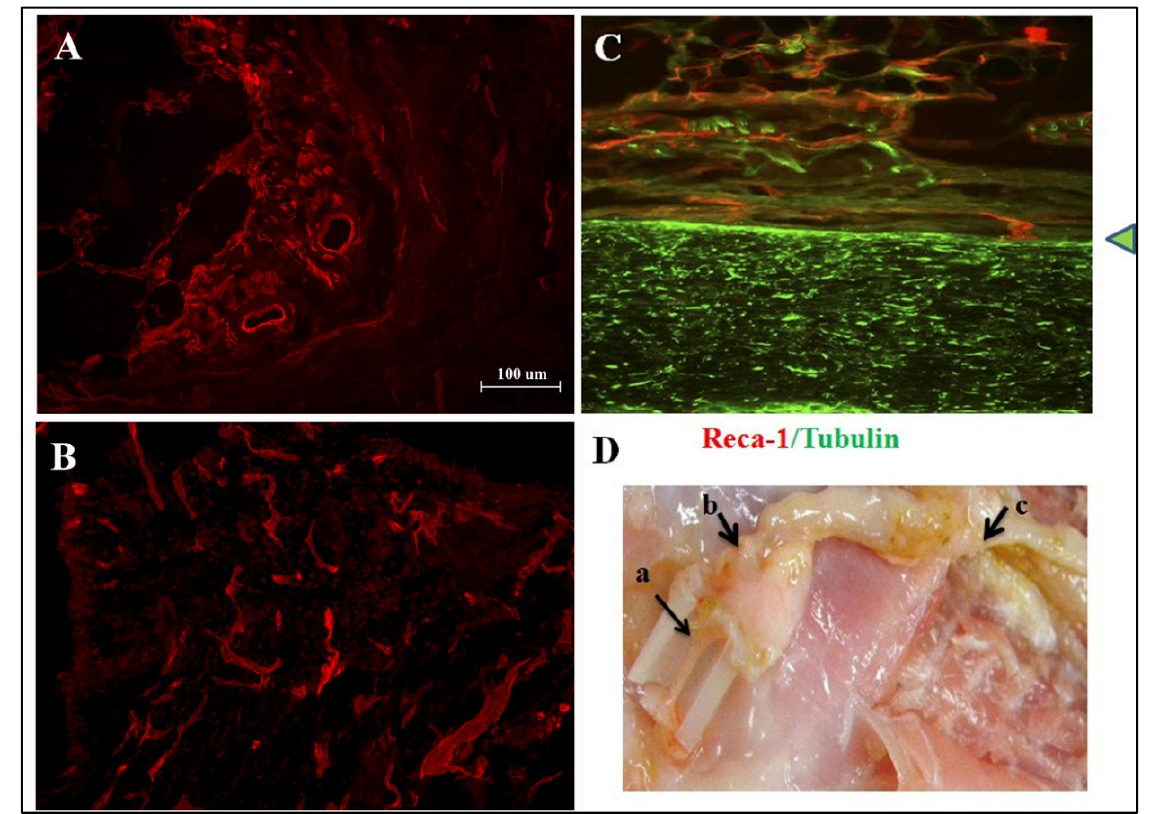
Figure 5. The omental flap remains vascularized at four weeks after transposition to the rat spinal cord. ( A ) RECA-1- immunoreactive omental flap inside the tubing (arrow a in D ). Scale bar = 100 µ m; × 200. ( B ) RECA-1-IR omental flap extruding from the tubing (arrow b in D ). ( C ) Omentum flap wrapping on the thoracic spinal cord (arrow c in D ); note that the arrowhead indicates dura matter; red: RECA-1(+) vessel in the omentum; green: tubulin (+) axons. ( D ) The route of omental transposition; the IHC results of a, b, c tissue sections are shown in A , B , C , respectively.